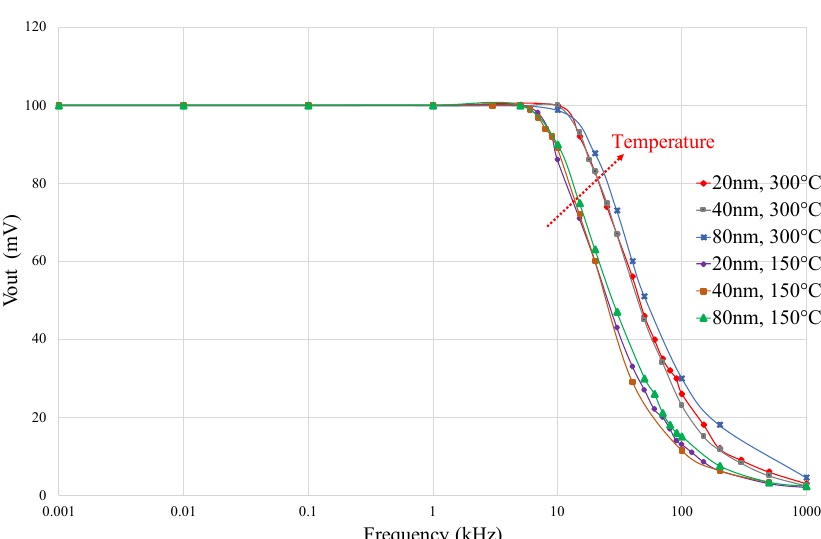
Figure 7. Output voltage over frequency for C i = C f = 10 nF, S 2 : OFF, V in = 100 mVpp.